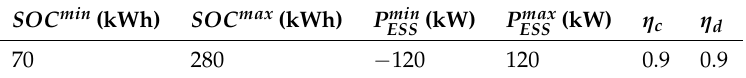
Table 4. ESS characteristic parameters.